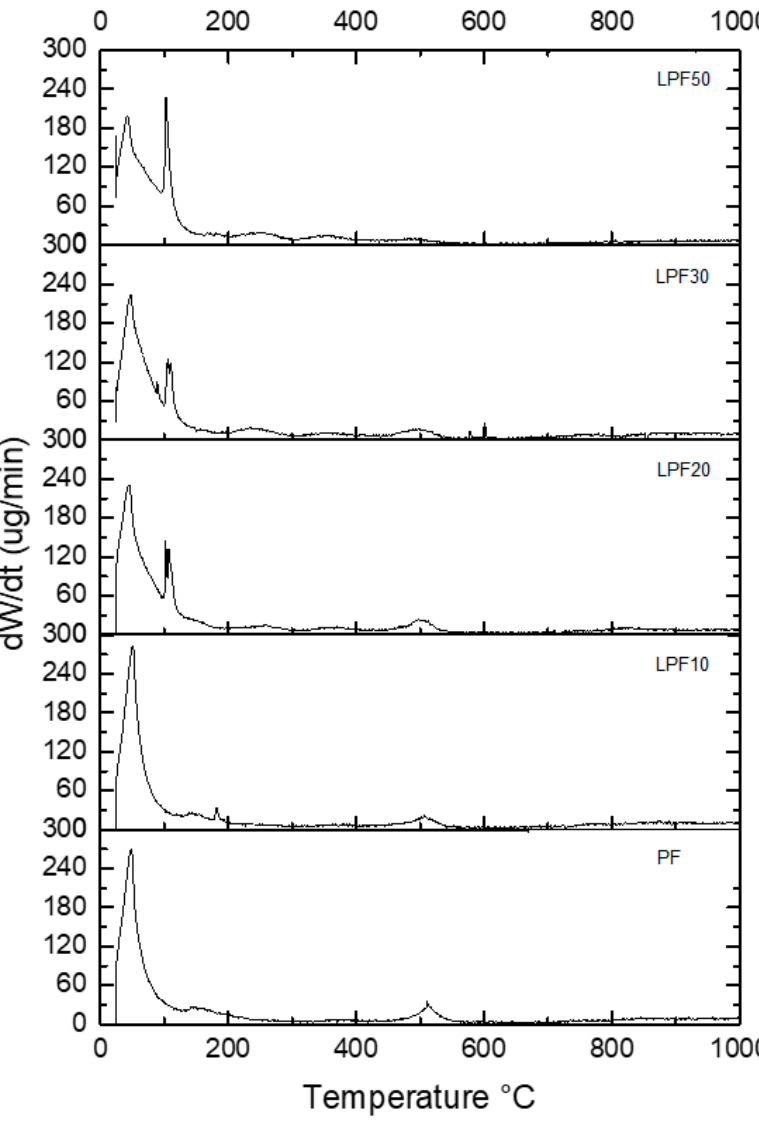
Figure 6. DTG curves of different resins.